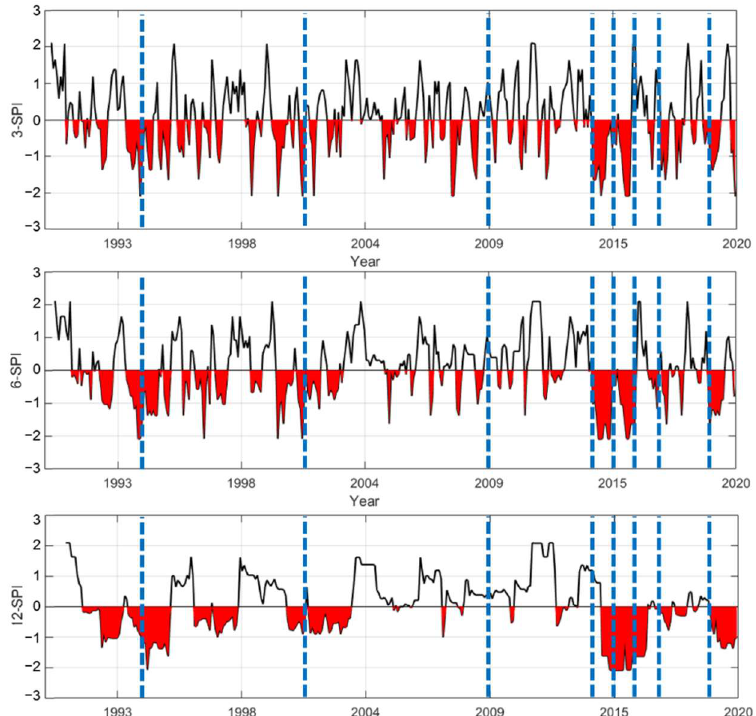
Figure 4. Standard precipitation index (SPI) for study site. The blue dotted lines indicate major droughts caused significant damage.